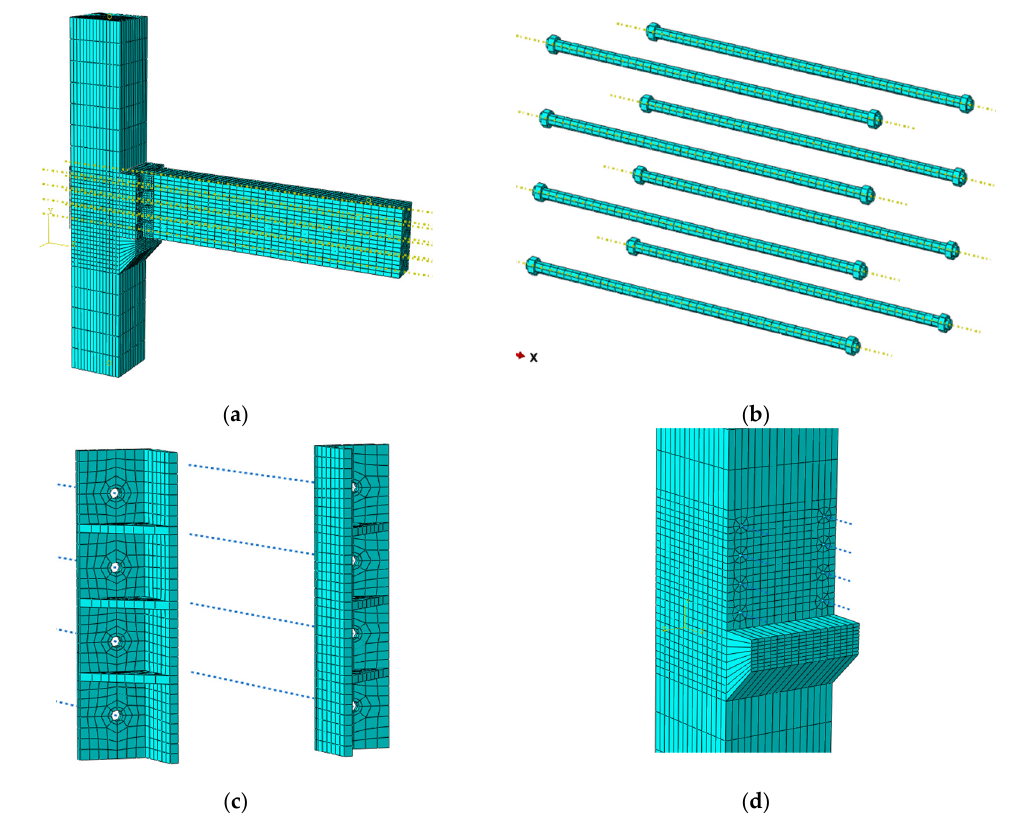
Figure 21. Specimen meshing diagram. ( a ) The whole specimen; ( b ) bolts; ( c ) steel haunched plates; ( d ) precast column bolt holes.